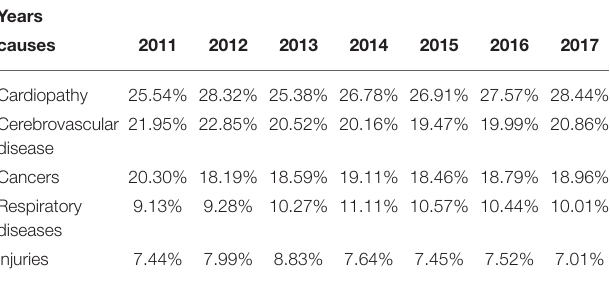
TABLE 3 | Statistics on the causes of death of Z City